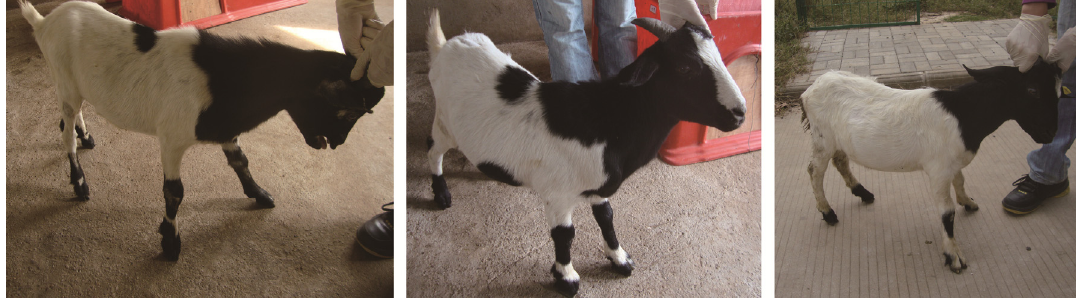
Figure 6. The white and black hair follicles were collected from three 1-year old crossbred black and white